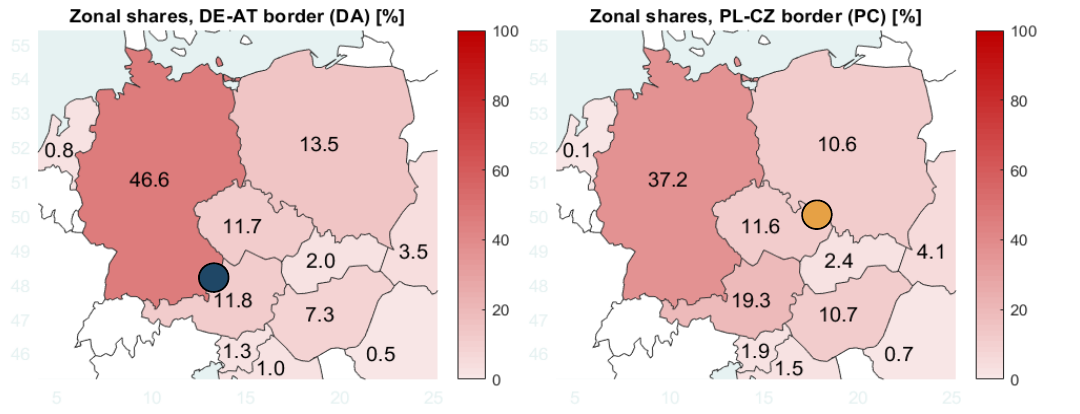
Figure 8. Investment shares for both locations of new PST (DA and PC)